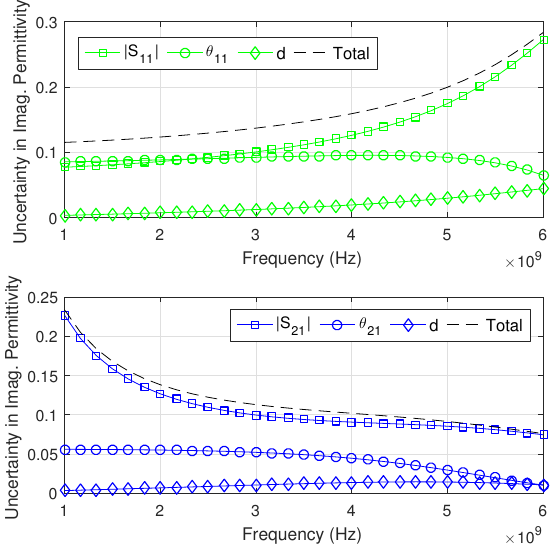
Figure 11. The uncertainty in the imaginary part of permittivity ( ∆ ε (cid:48)(cid:48) r ) due to the uncertainties in the magnitude and phase of the S-Parameters and in the thickness d . The reflection configuration is on the top; the transmission is on the bottom.